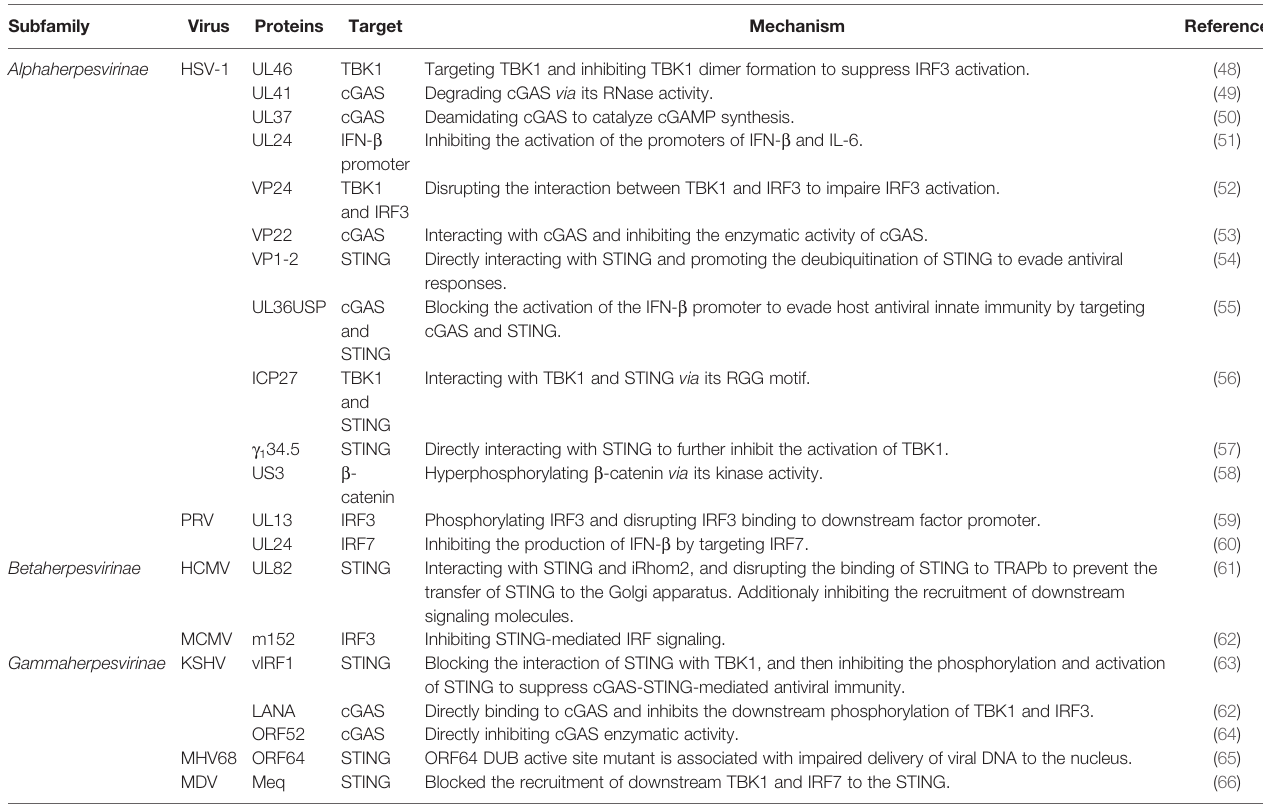
TABLE 1 | Herpesvirus evasion of innate immunity via cGAS-STING signaling pathway. Subfamily Virus Proteins Target Mechanism Reference